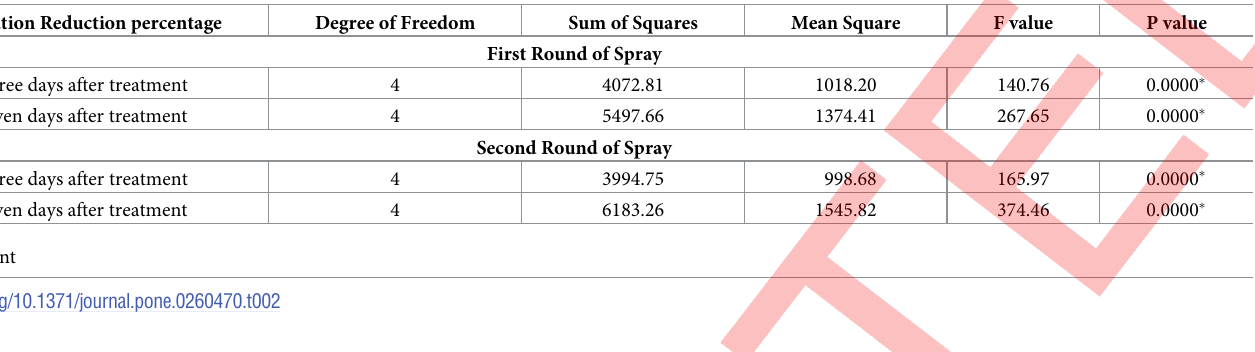
Table 2. Analysis of variance for effect of natural insecticides on population reduction percentage of H . armigera after three and seven days of first and second round of spray.